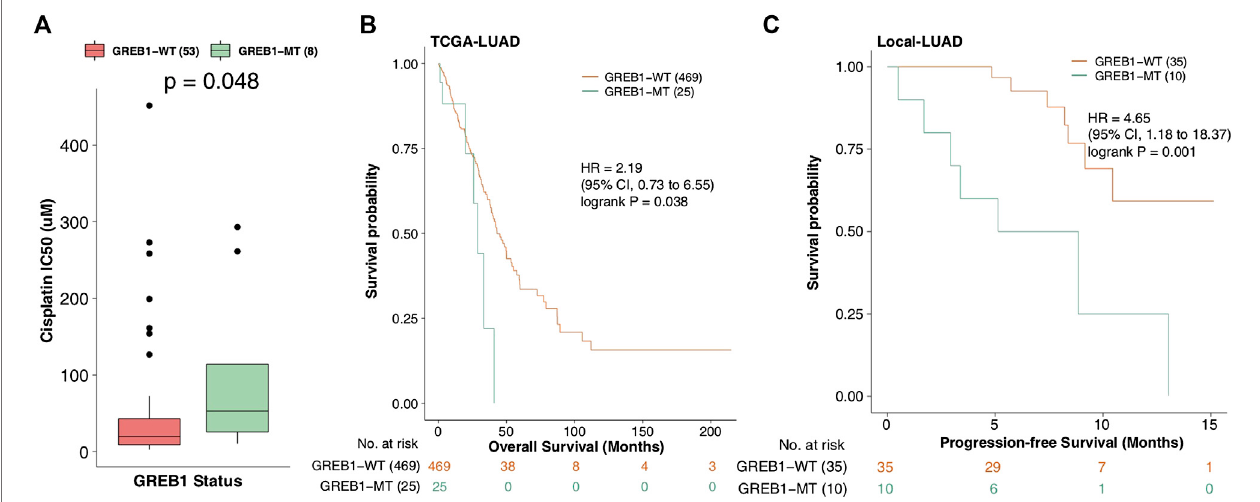
FIGURE 2 | (A) IC50 values for CDDP in GDSC-LUAD cell lines with or without GREB1 mutations. (B) Regarding OS, the Kaplan-Meier method revealed GREB1 mutations (green) and wild-type GREB1 (orange) for the dataset of 494 patients with LUAD (TCGA database). (C) Regarding PFS, the Kaplan-Meier method revealed GREB1 mutations (green) and wild-type GREB1 (orange) in the dataset of 45 patients with LUAD (Local-LUAD cohort). IC50, half maximal inhibitory concentration; CDDP, cis -diamminedichloroplatinum(II); GDSC, Genomics of Drug Sensitivity in Cancer; LUAD, lung adenocarcinoma; OS, overall survival; TCGA, The Cancer Genome Atlas; PFS, progression-free